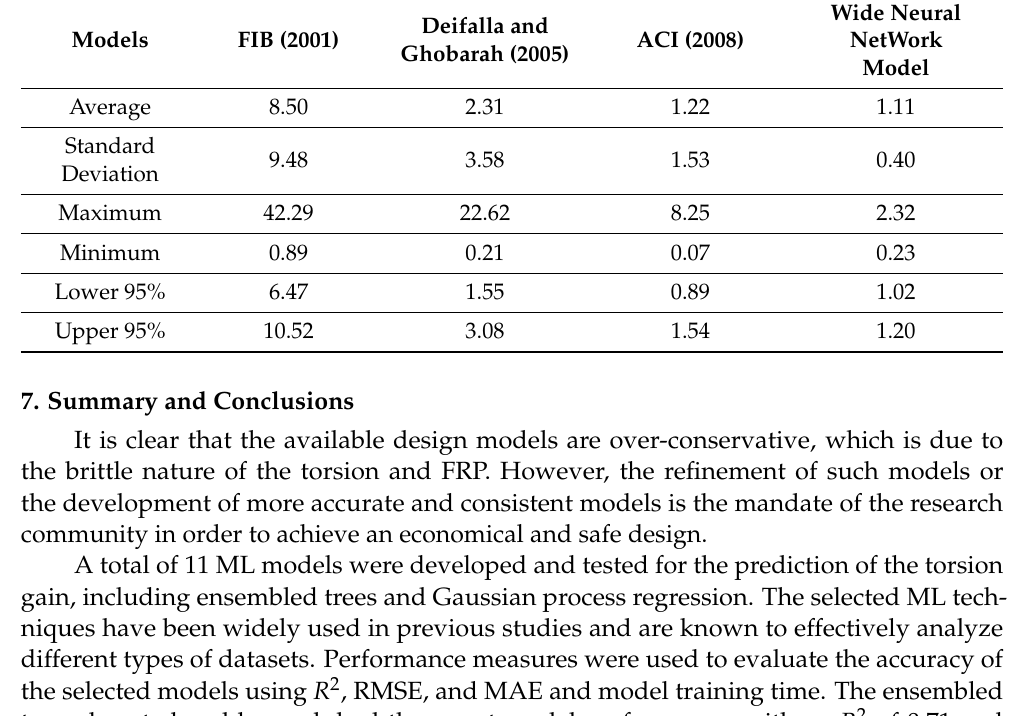
Table 6. Comparing ratio of measured and predicted torsion strength from various models.